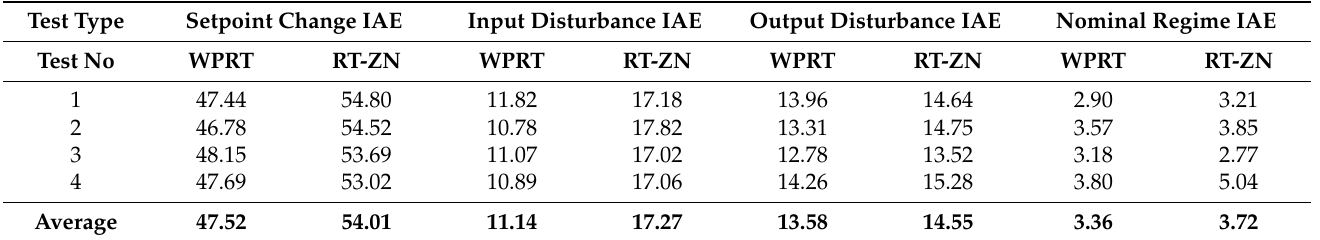
Table 1. Table of comparative results of integral absolute error (IAE) for four different experiments, each repeated four